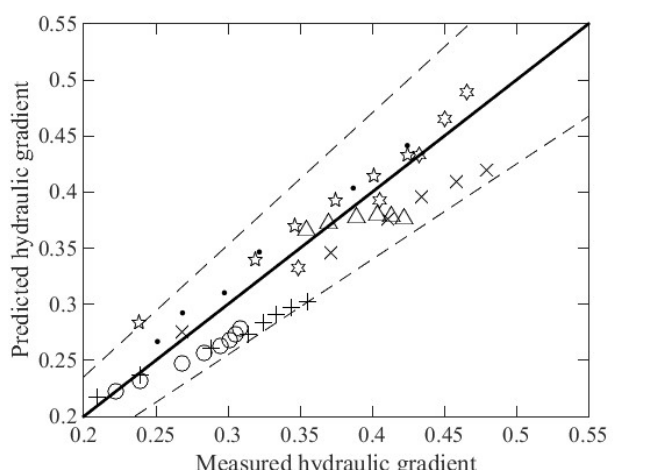
Fig. 7. Parity plot comparing observed and predicted